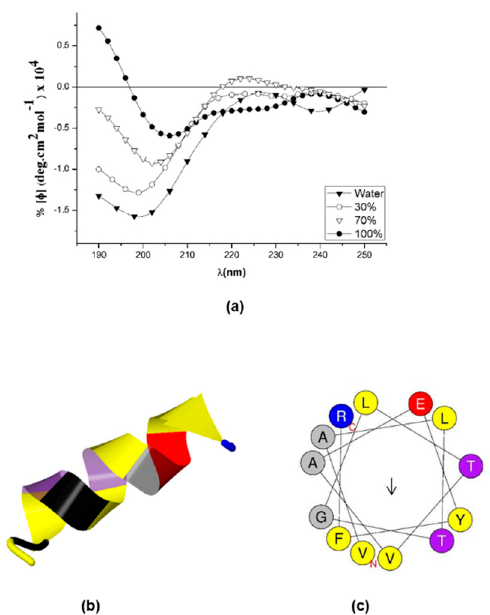
Figure 5. Sarconesin II secondary structure. ( a ) A Jasco-1500 instrument was used for measuring sarconesin II’s circular dichroism spectrum. Sarconesin II CD spectra variation at 0%, 30%, 70% and 100% trifluoroethanol (TFE) concentrations ( b ). I-TASSER sarconesin II secondary structure gave an α -helix, depicted in spiral ribbon format, using common colors. ( c ) Computation of sarconesin II α -helical wheel [54]. No hydrophobic face reported. Note slightly opposite arrangement of hydrophobic (yellow) versus charged (red, blue) aa.